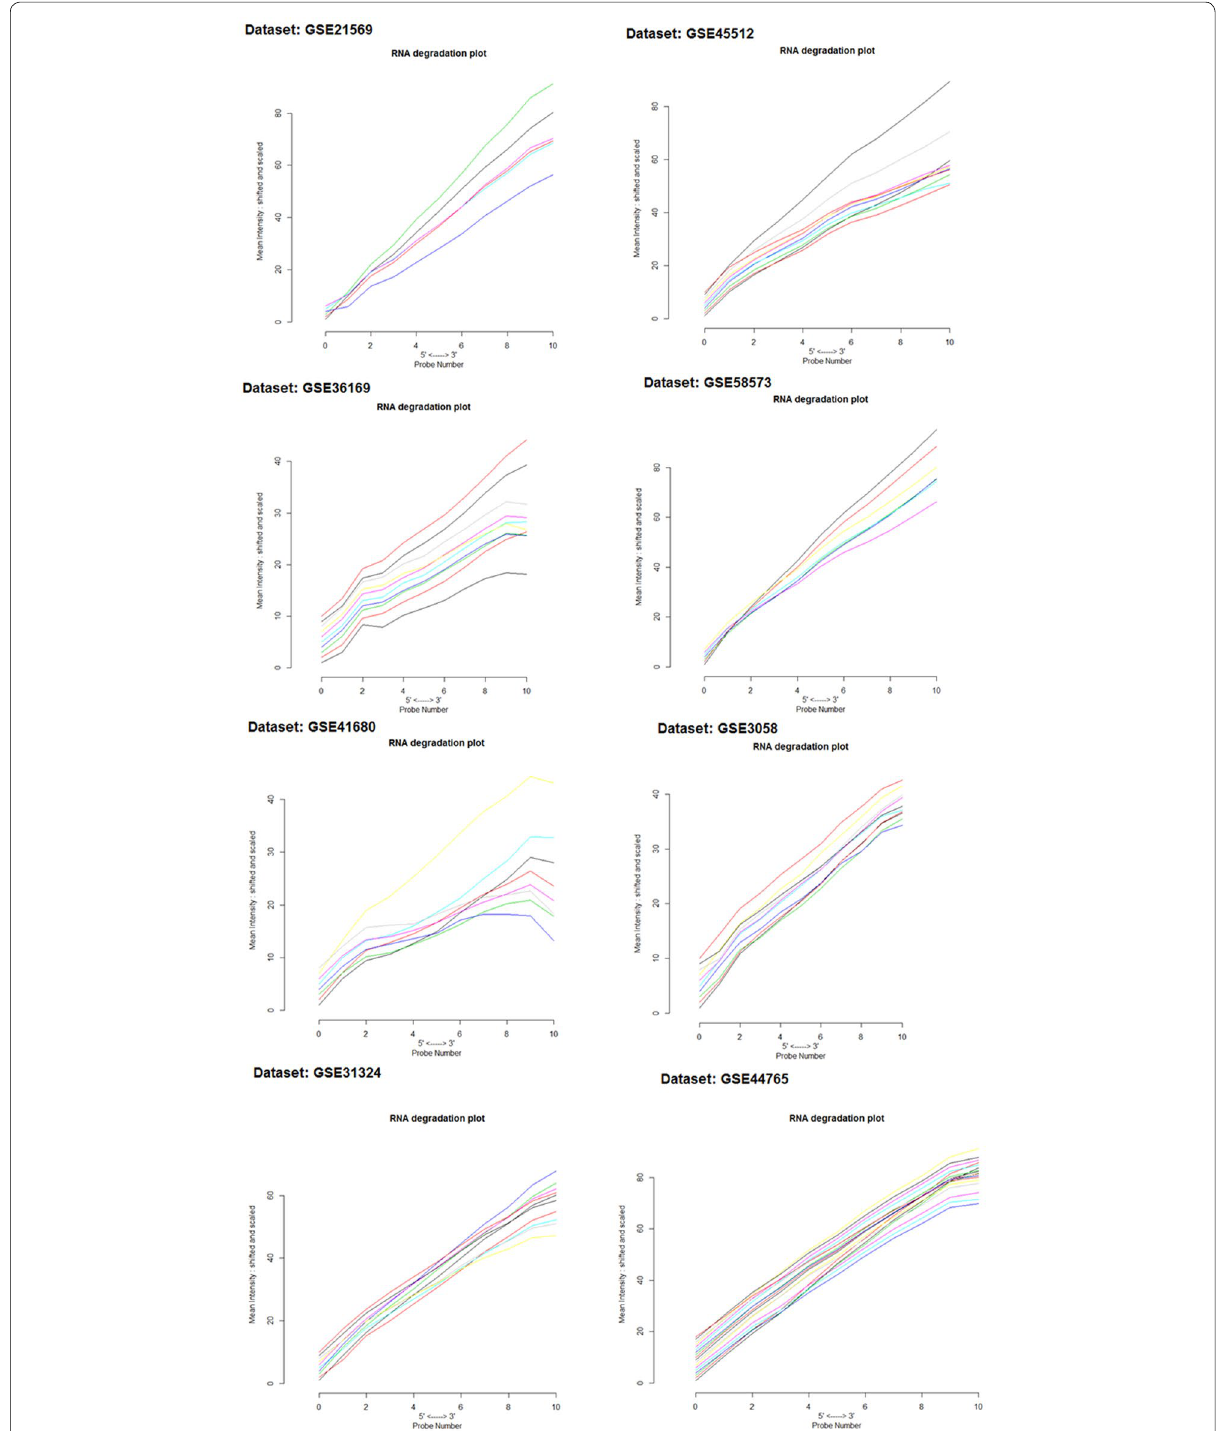
Fig. 2 RNA degradation plot of each dataset: side-by-side plot produced by plotAffyRNAdeg representing 5 ′ to 3 ′ trend presenting an assessment of the severity of degradation and significance